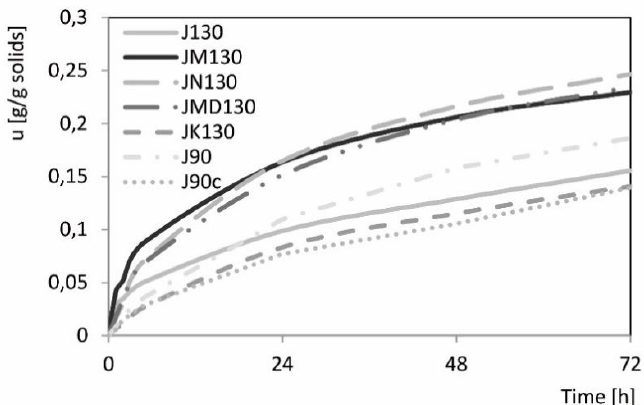
Figure 4. Water vapor adsorption kinetics of obtained cloudy beetroot juice powders (abbreviations of variants explained in Table